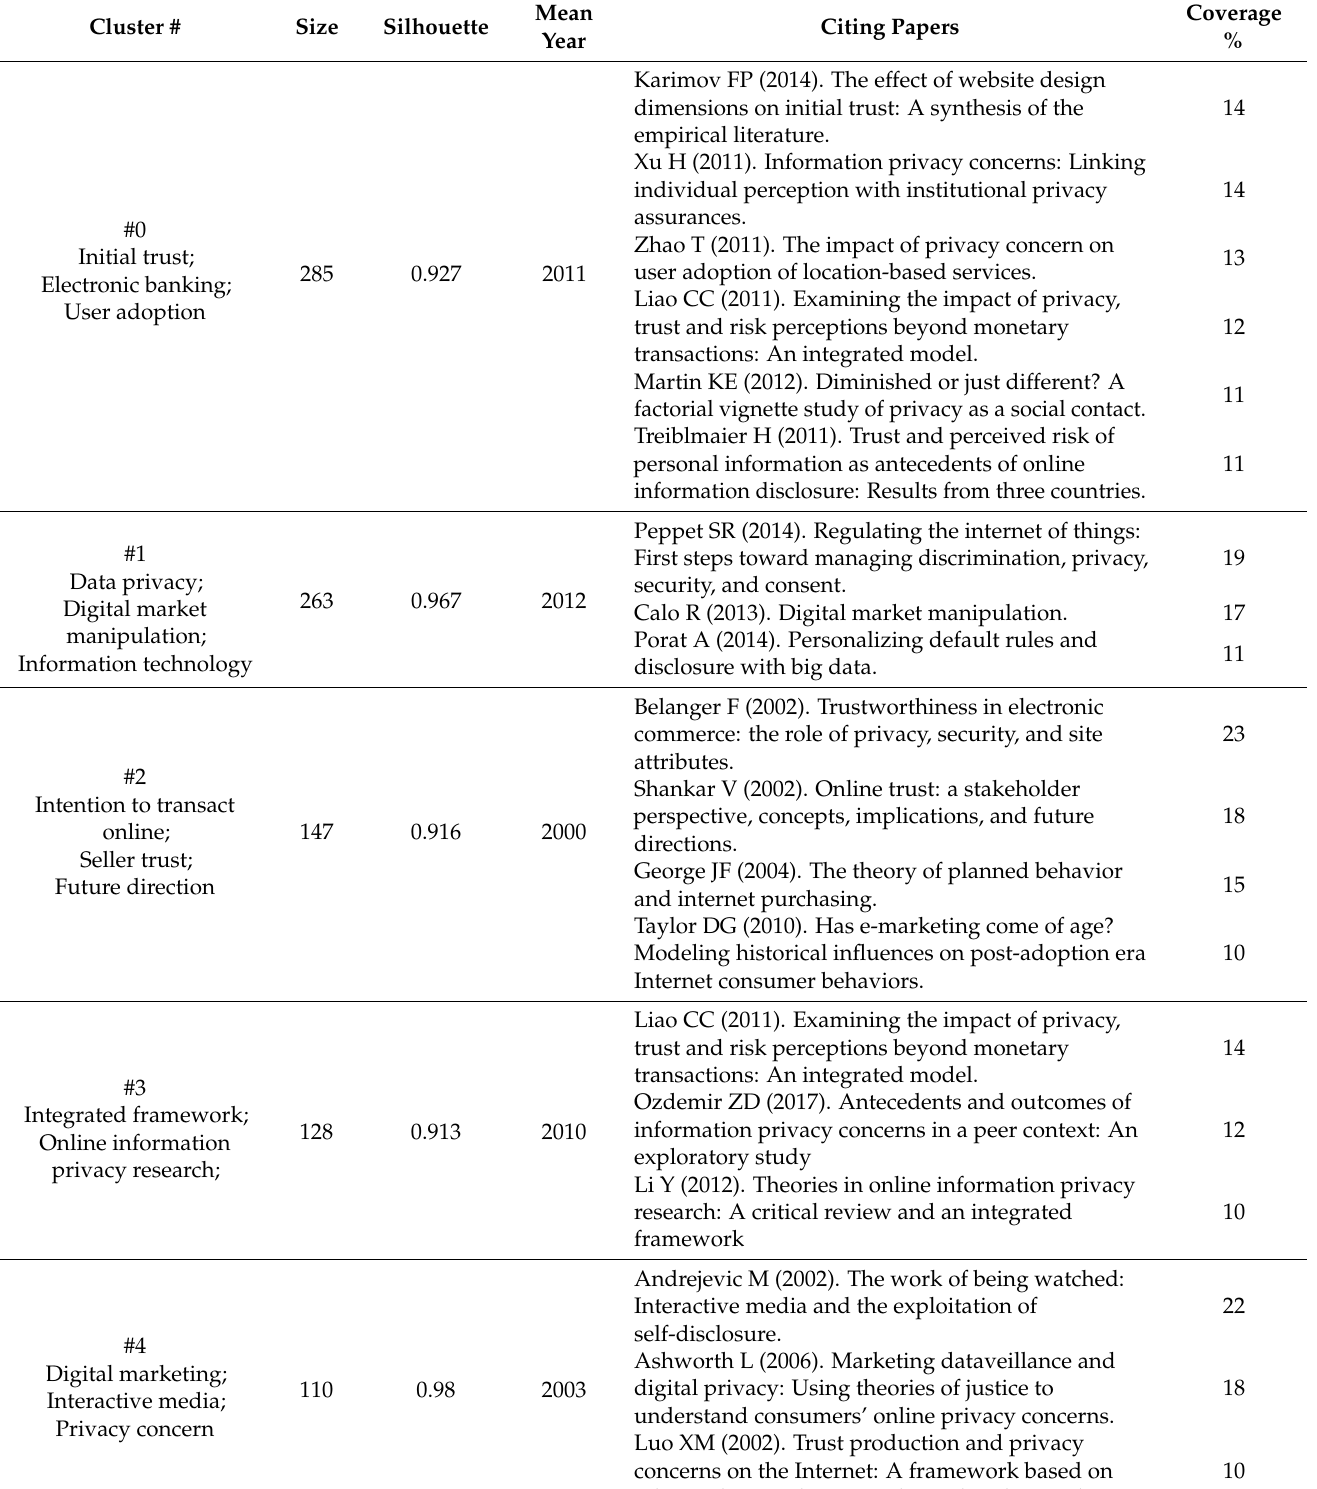
Table 3. Representative papers of main